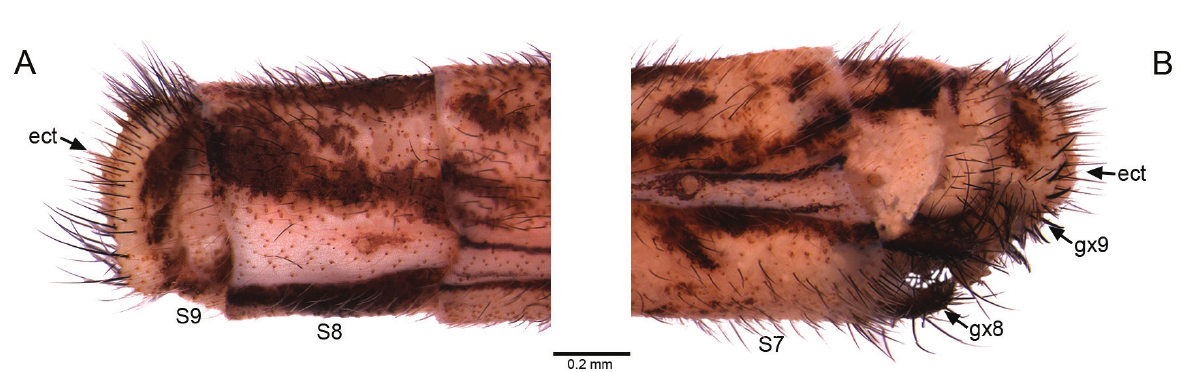
Figure 7. Megistopus lucasi : male and female terminalia, lateral view. A male [Italy, Sardinia]; B female [Italy, Sardinia]. Abbrevia- tions: ect – ectoproct, S9 – sternite 9, gx9 – gonocoxite 9, S8 – sternite 8, gx8 – gonocoxite 8, S7 – sternite